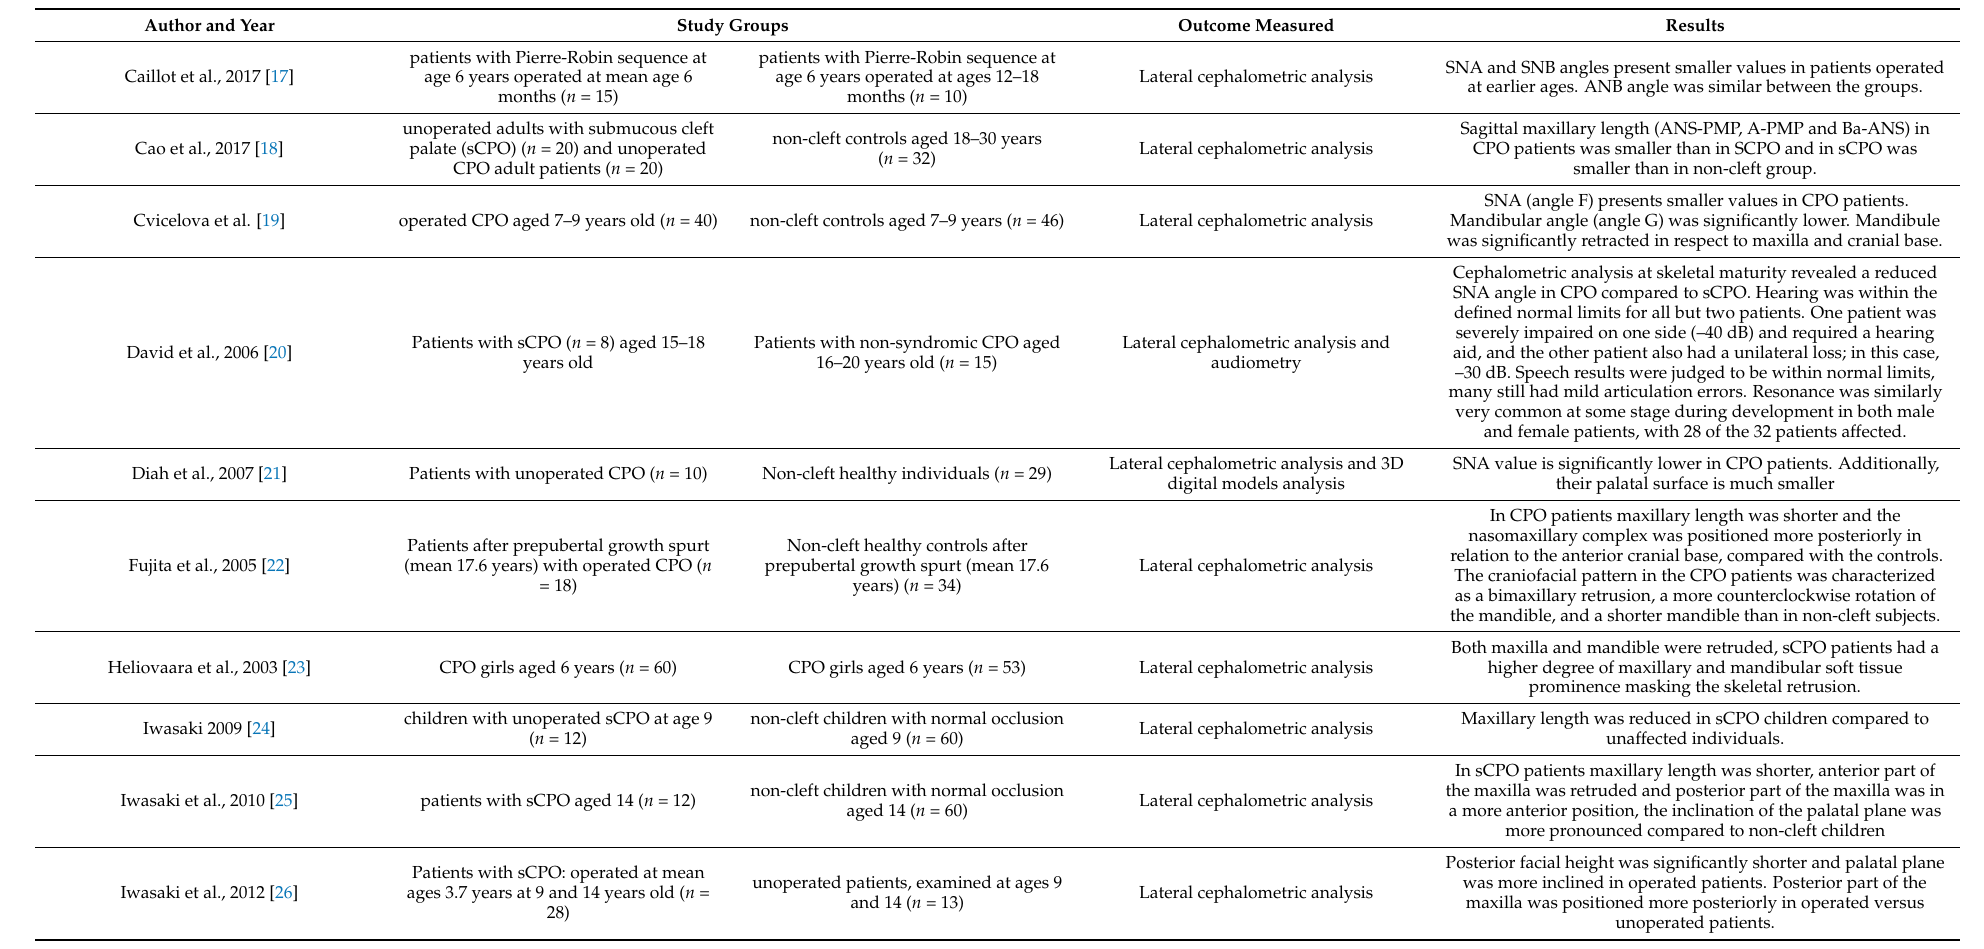
Table 1. Characteristics of included